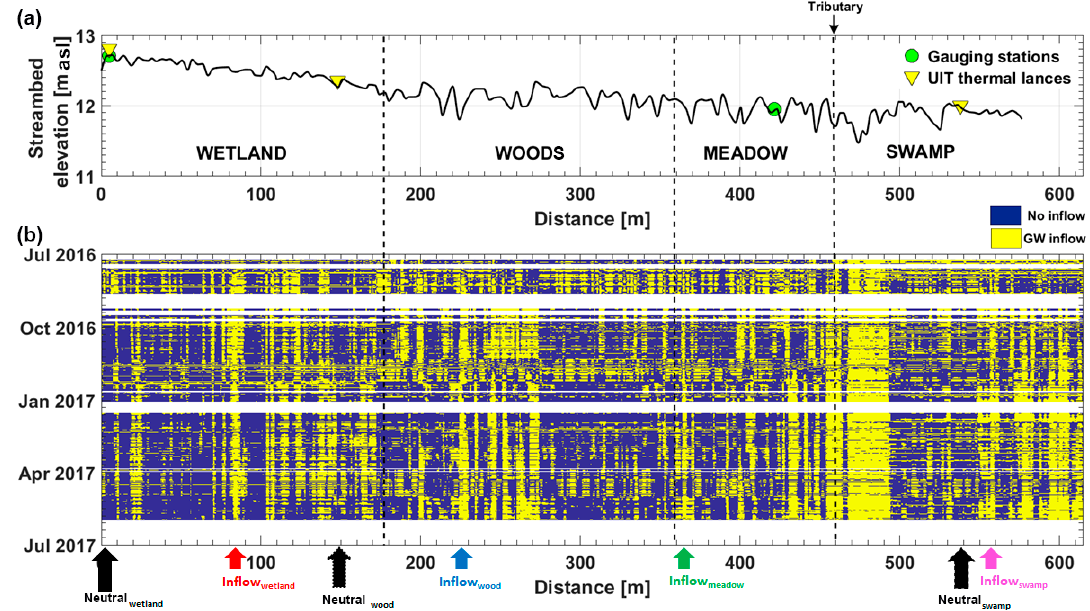
Figure 3. ( a ) Longitudinal profile of the streambed in the four sub-reaches of the monitored reach. UIT = Umwelt-und Ingenieurtechnik, m asl = m above sea level. ( b ) Spatio-temporal evolution of thermal anomalies [40]. Arrows indicate representative points of groundwater (GW) inflow and no inflow (Neutral). White strips show periods when the distributed temperature sensing system malfunctioned (horizontal) or points where the cable was often non-submerged (vertical).